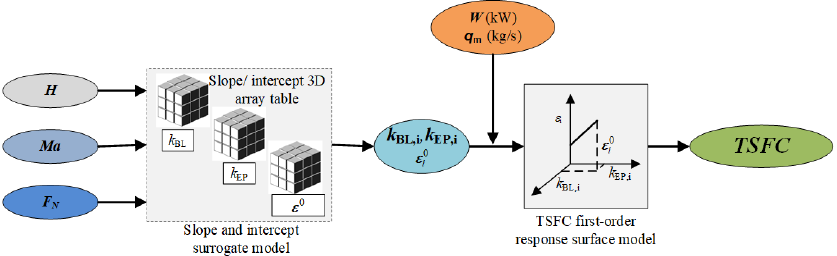
Figure 8. The calculation process schematic diagram of the TSFC surrogate model.